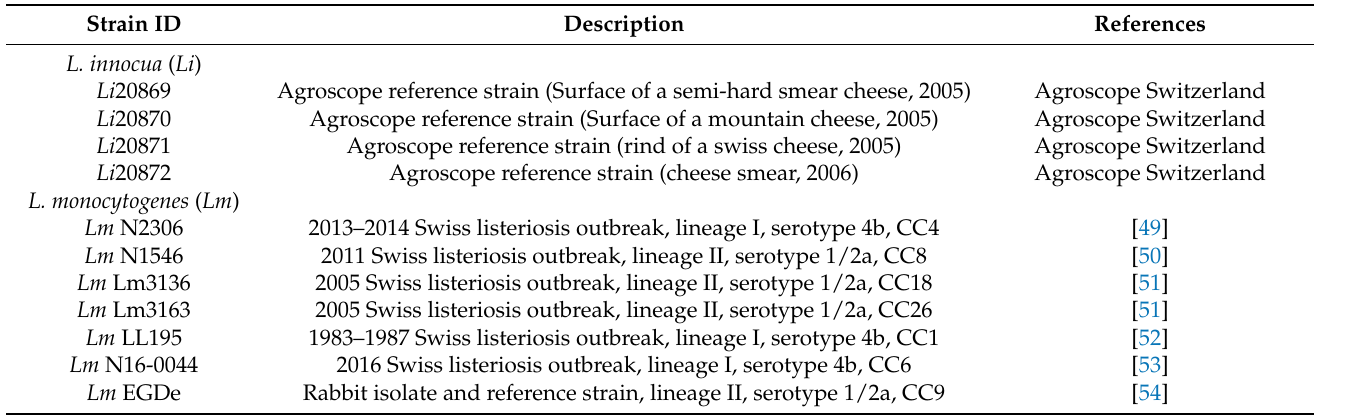
Table 1. Strains used in this